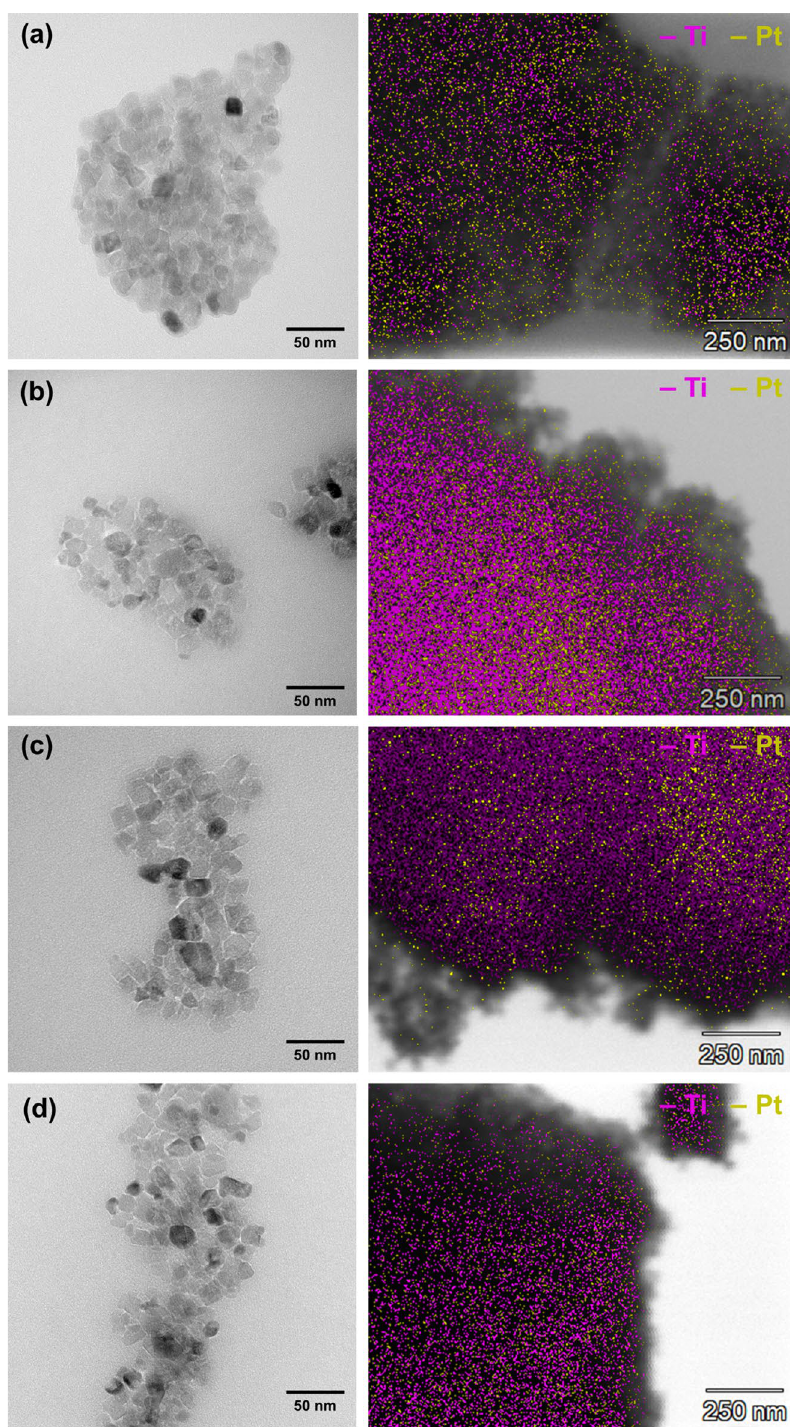
Figure 5. The TEM and EDS map (pink color means titanium; yellow color means platinum) images for selected samples: ( a ) 1 W 365 nm, ( b ) 10 W 365 nm, ( c ) 1 W 395 nm, and ( d ) 10 W 395